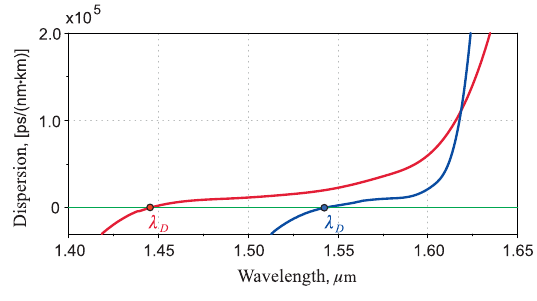
Figure 6: Dispersion of the fundamental TE 0 mode. Red and blue curves correspond to two particular configurations of a Bragg reflec- tion waveguide with periodic and aperiodic cladding, respectively. Green line represents level D = 0 [ps/(nm ·